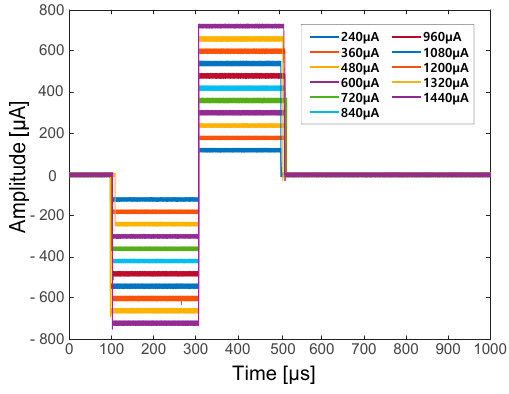
Figure 13. Converted VCCS output current waveforms with a 1 k Ω load resistor.